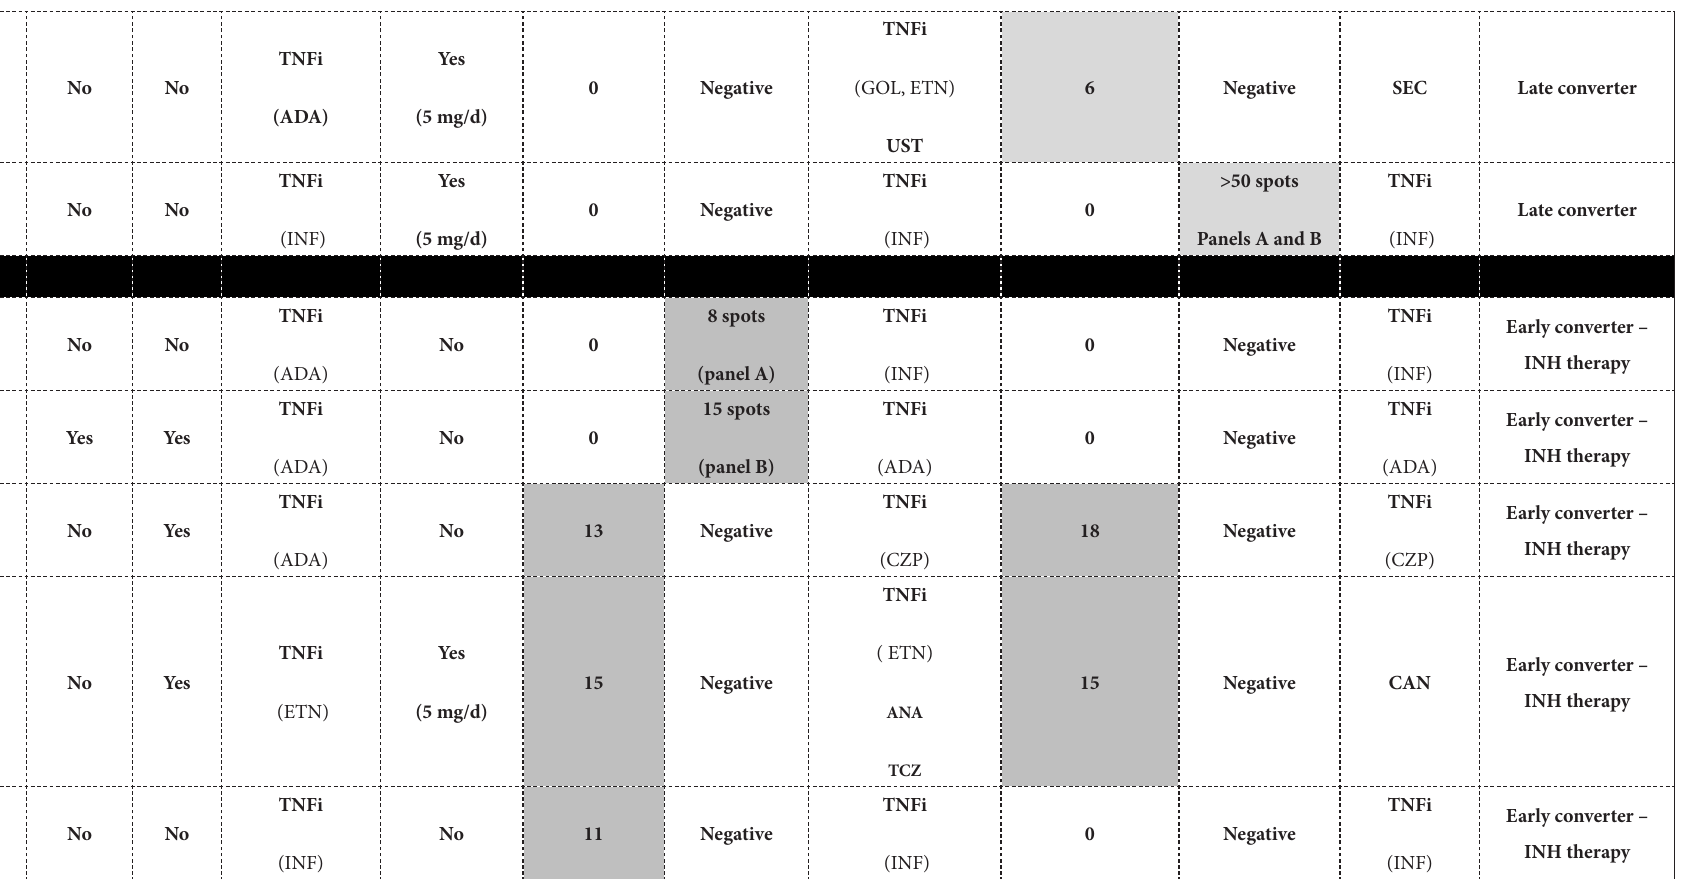
The characteristics of the 15 patients who converted TST or T-SPOT.TB (grey boxes) are shown. This includes those who remained positive at both re-screenings (“persistent converters”, n=2, #1-2)), those who reversed from positive to negative between the first and second rescreening without isoniazid (INH) therapy (“transient converters”, n=3, #3-5), those who converted between the first and second rescreening (“late converters”, n=5, #6-10), and finally the converters at the first rescreening who received INH ther- apy (“early converters on INH therapy”, n=5, #11-15). * Expressed as prednisolone equivalent dose (in